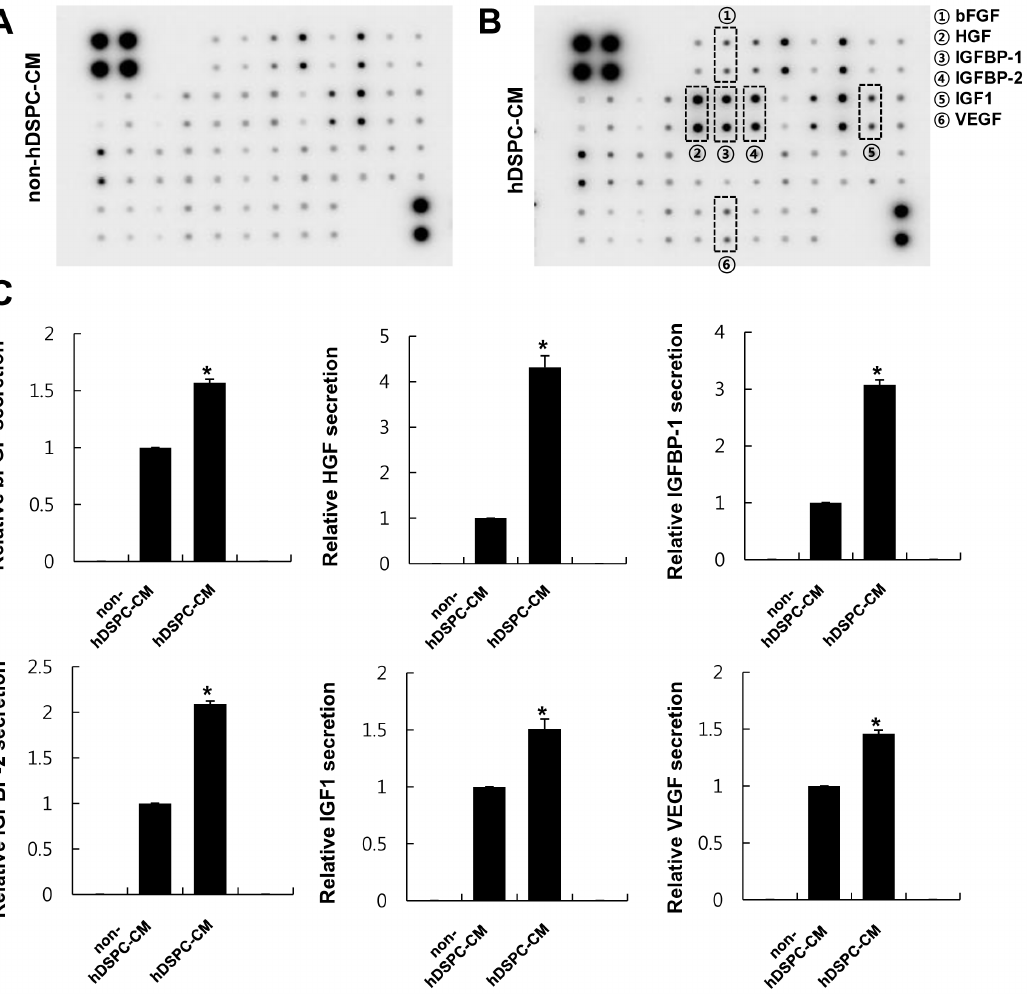
Figure 1. The secretion levels of specific growth factors were increased in hDSPC-CM. Growth factor secretion profiles of non-hDSPC-CM (A) and hDSPC-CM (B) using a human growth factor antibody array, respectively. Relative secretion levels of bFGF, HGF, IGFBP-1, IGFBP-2, IGF1, and VEGF in serum-free hDSPC-CM compared with non-hDSPC-CM (C). The graphs are shown as the mean 6 S.D. of three independent experiments. * p , 0.01.